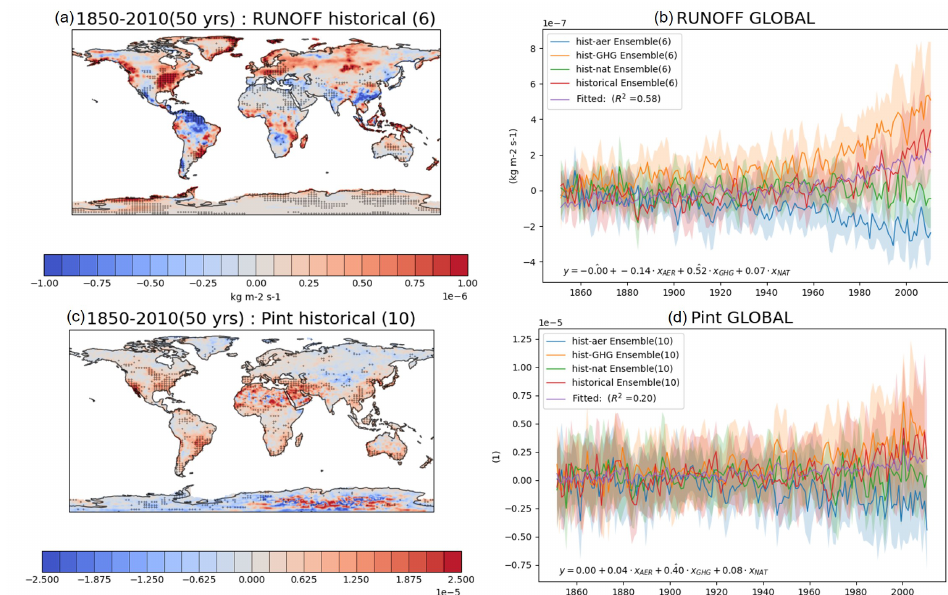
Figure 7. Results of runoff (RUNOFF) and precipitation intensity (Pint): ( a ) 50-year mean start-to-end difference in RUNOFF; ( b ) time series plot of global RUNOFF; ( c ) 50-year mean start-to-end difference in Pint; ( d ) time series plot of global Pint. The titles above the plots and the legends within the plots are followed by the number of ensemble models in parentheses, and the estimated parameters with hats provide the statistical significances. On the maps, dots indicate where the differences are significant ( p -value ≤